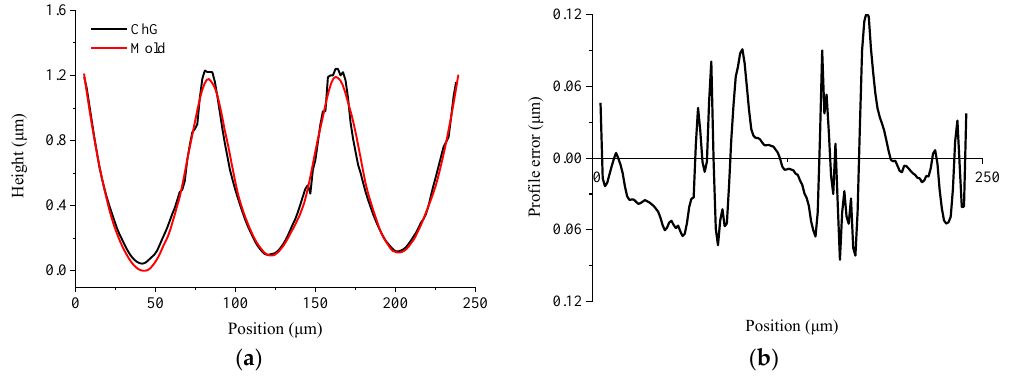
Figure 25. The profile curves of microlens arrays: ( a ) microlens arrays on the mold and the ChG, and ( b ) profile error of microlens arrays.